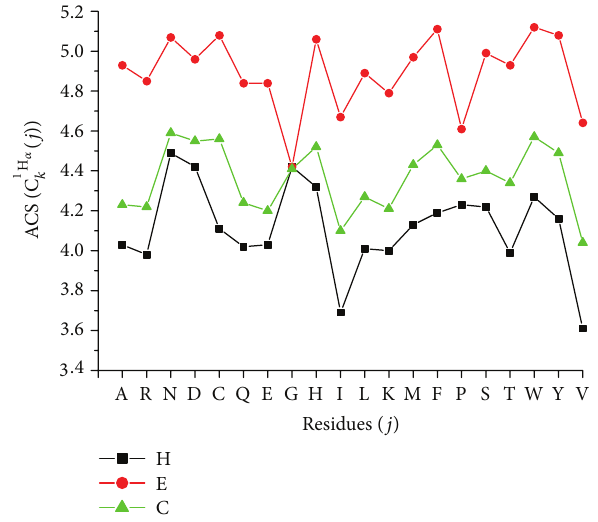
Figure 1: The average chemical shifts (ACS) of 1 H 𝛼 for each of 20 native amino acid residues ( 𝑗 ) with three types of secondary structure ( 𝑘 ).